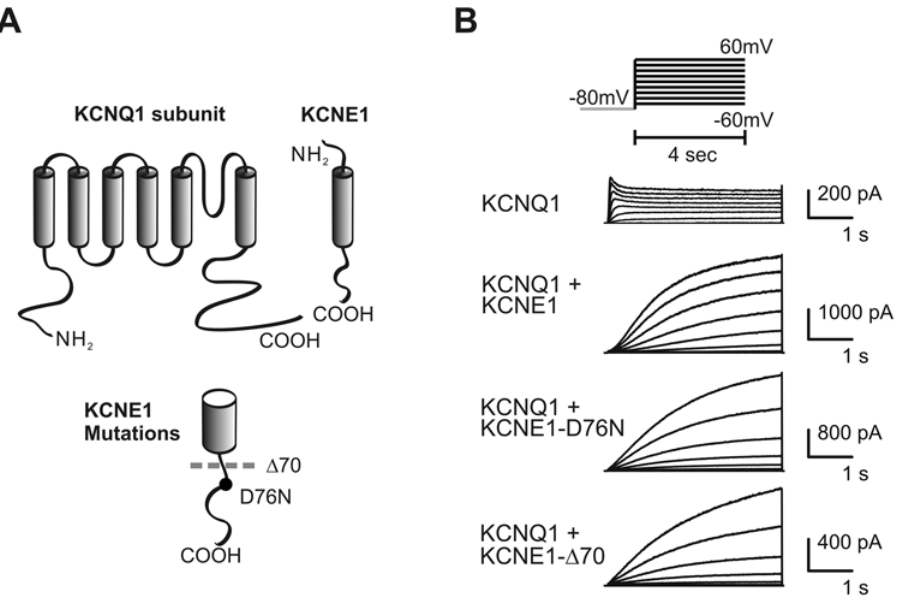
Figure 1. A) Schematic of KCNQ1 subunit and KCNE1, showing location of KCNE1 mutations. B) Current traces of activation protocol, with protocol in